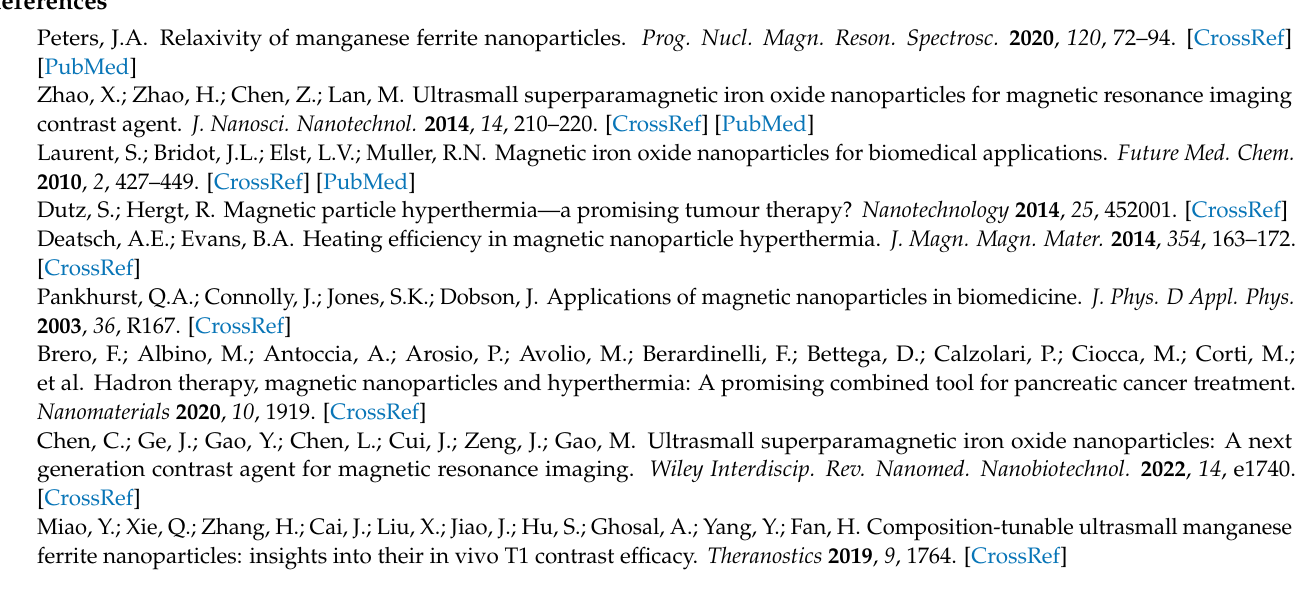
vs. time (A); Figure S4: Stability vs. time (B); Figure S5: Stability vs. time (C); Table S1: Precursors amount; Table S2: Samples